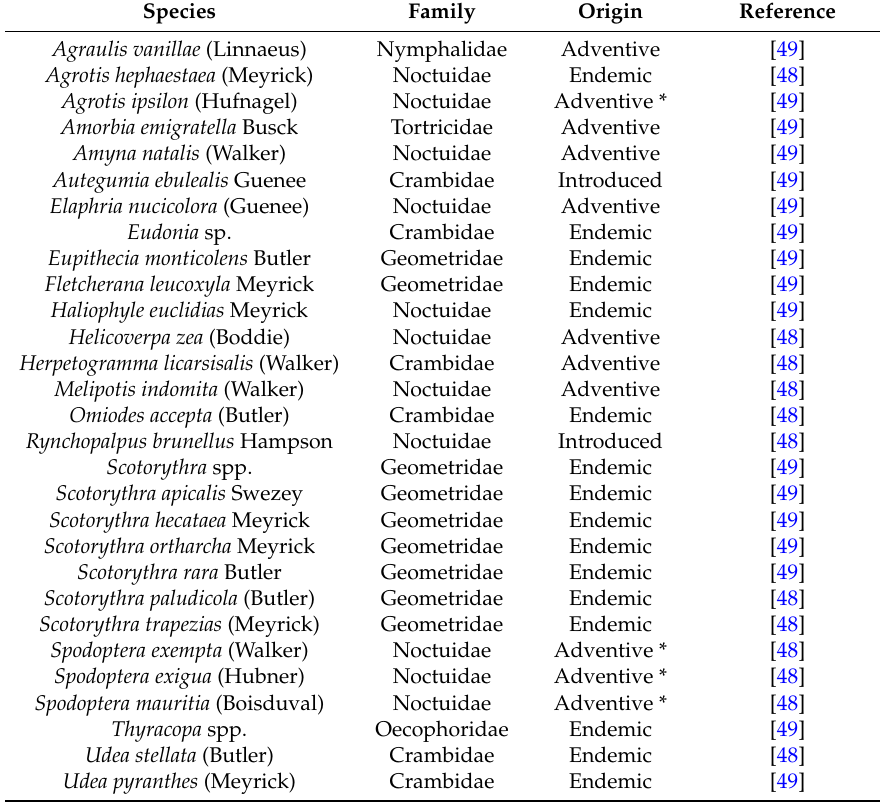
Table 2. List of known hosts of M. laphygmae in Hawaii (adventive = accidental introduction, Introduced = purposely